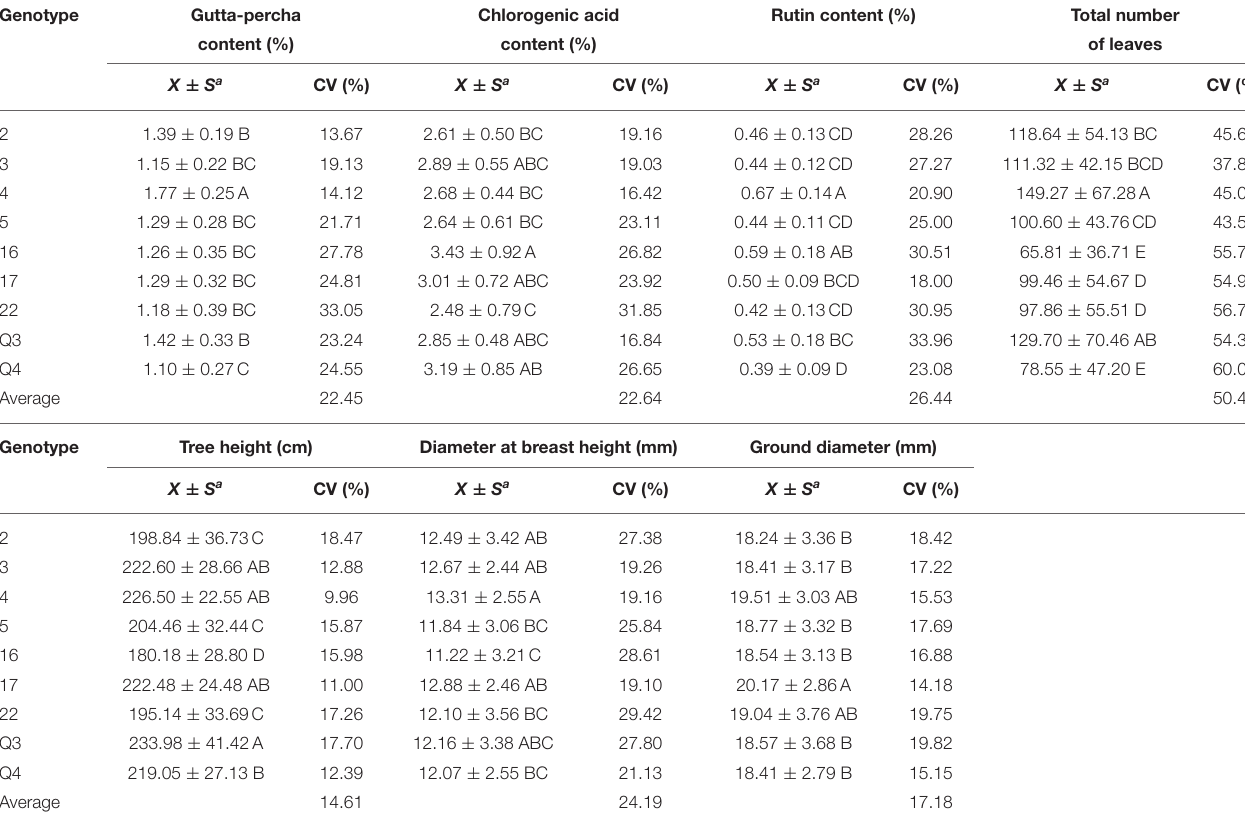
TABLE 4 | Multiple comparisons for traits among genotypes. Genotype